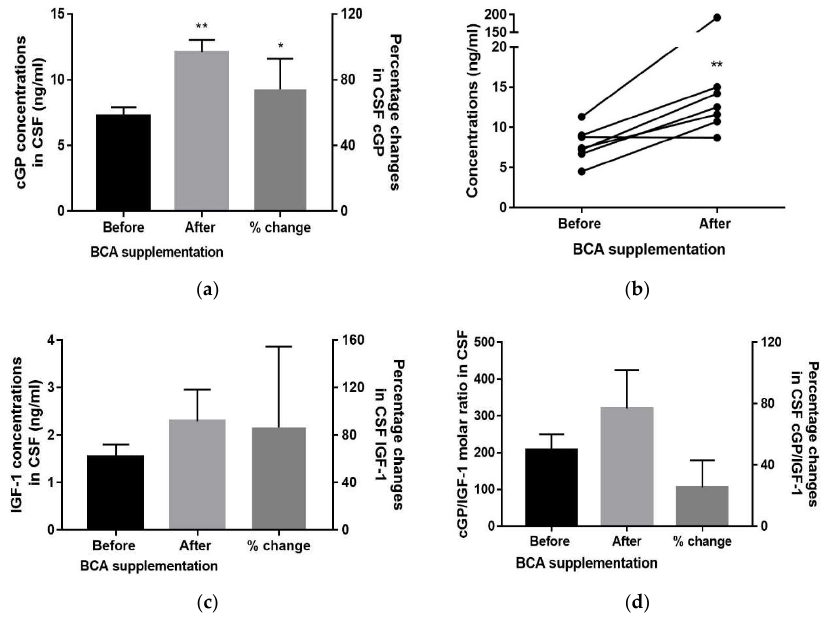
Figure 3. The changes in the CSF before and after supplementation of the BCA. ( a ) The concentration of cGP in the CSF was significantly increased after the supplementation compared to that prior to the supplementation. The percentage changes of cGP concentrations were significantly increased in the CSF. ( b ) There 6/7 paired samples showed an increase in cGP after supplementation, with one pair of samples increased by 16.9 times. cGP concentration of 1 pair of samples remained the same after the supplementation. ( c ) There was no statistical difference in IGF-1 concentration and percentage change of IGF-1 in the CSF. ( d ) There was no statistical difference in the cGP/IGF-1 ratio and percentage change of the ratio. Data presented as mean ± SEM and the percentage change from the baseline, * p < 0.05, ** p <